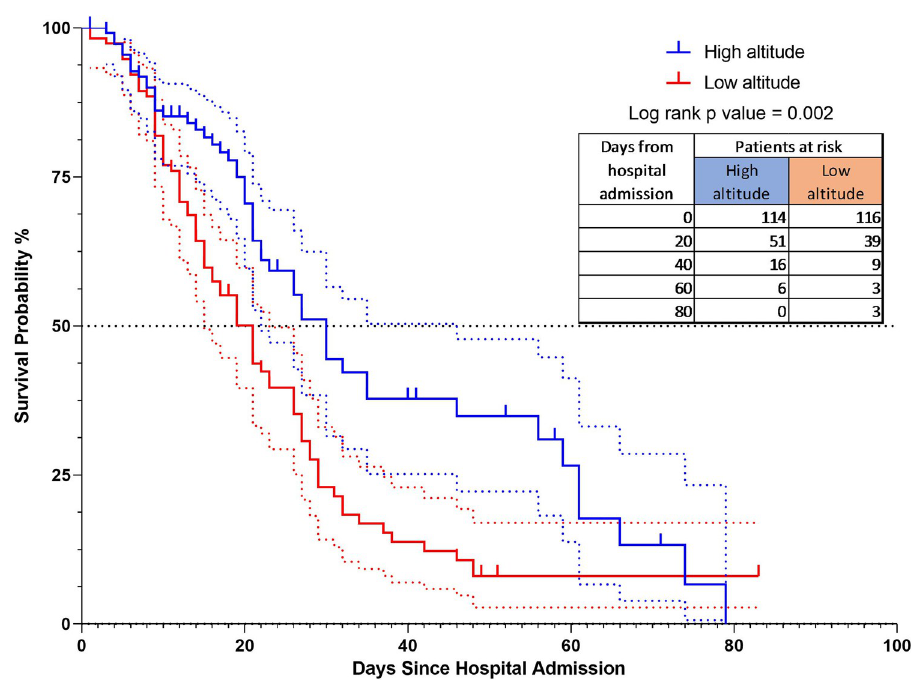
Fig 3. The Kaplan-Meier curves for mortality according to altitude. All comparisons were calculated using a COX regression multivariate analysis.